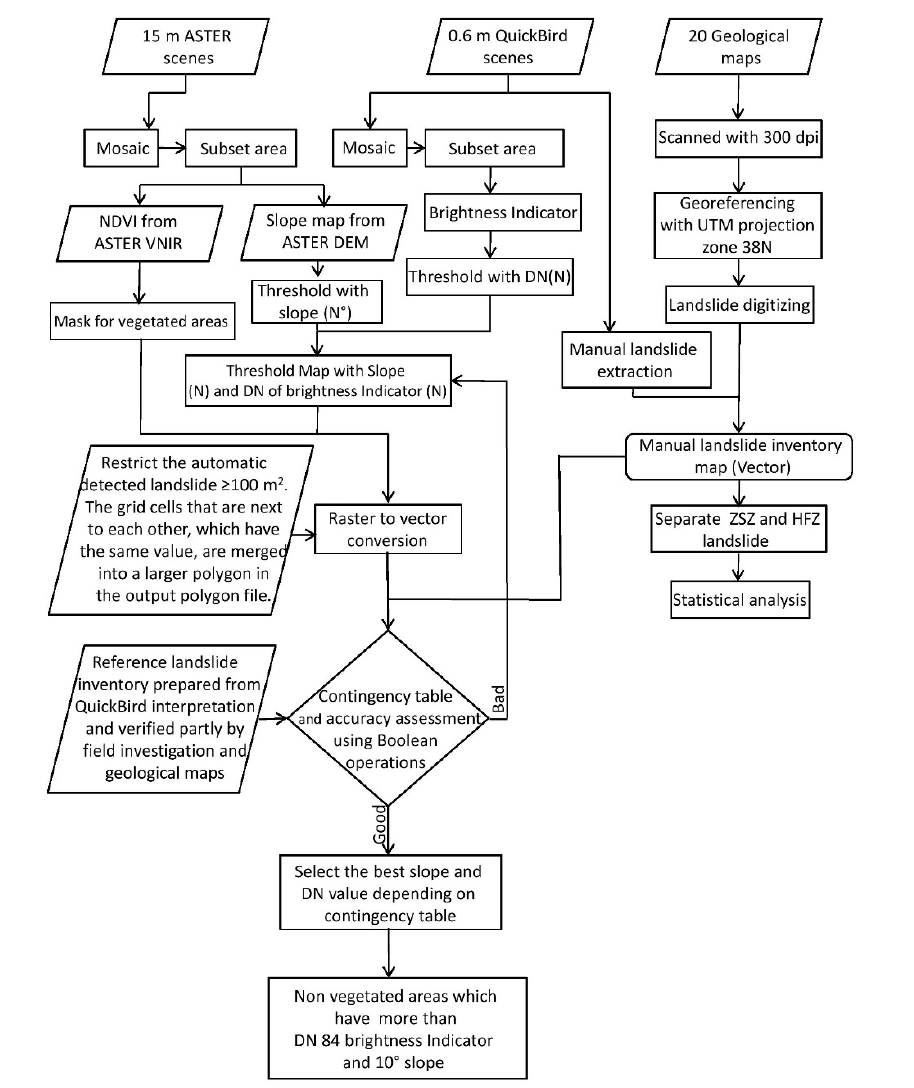
Figure 7. General methodology.